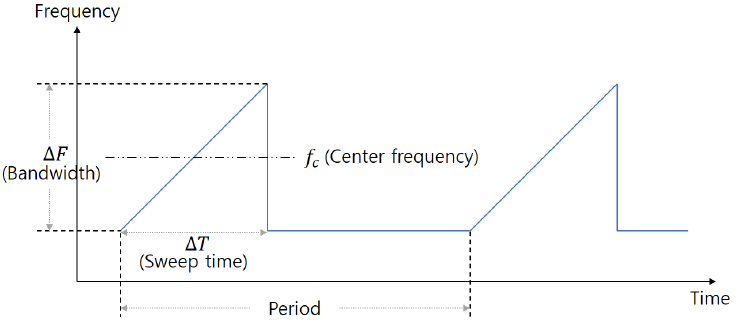
Figure 2. FMCW radar signal generated from the